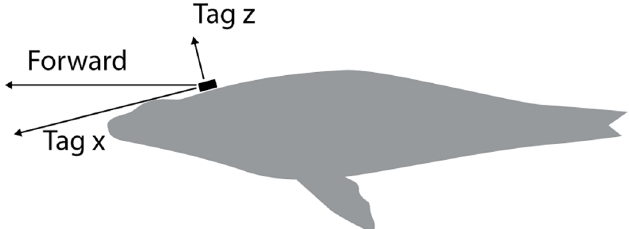
Fig 6. The tag axes are shown relative to the